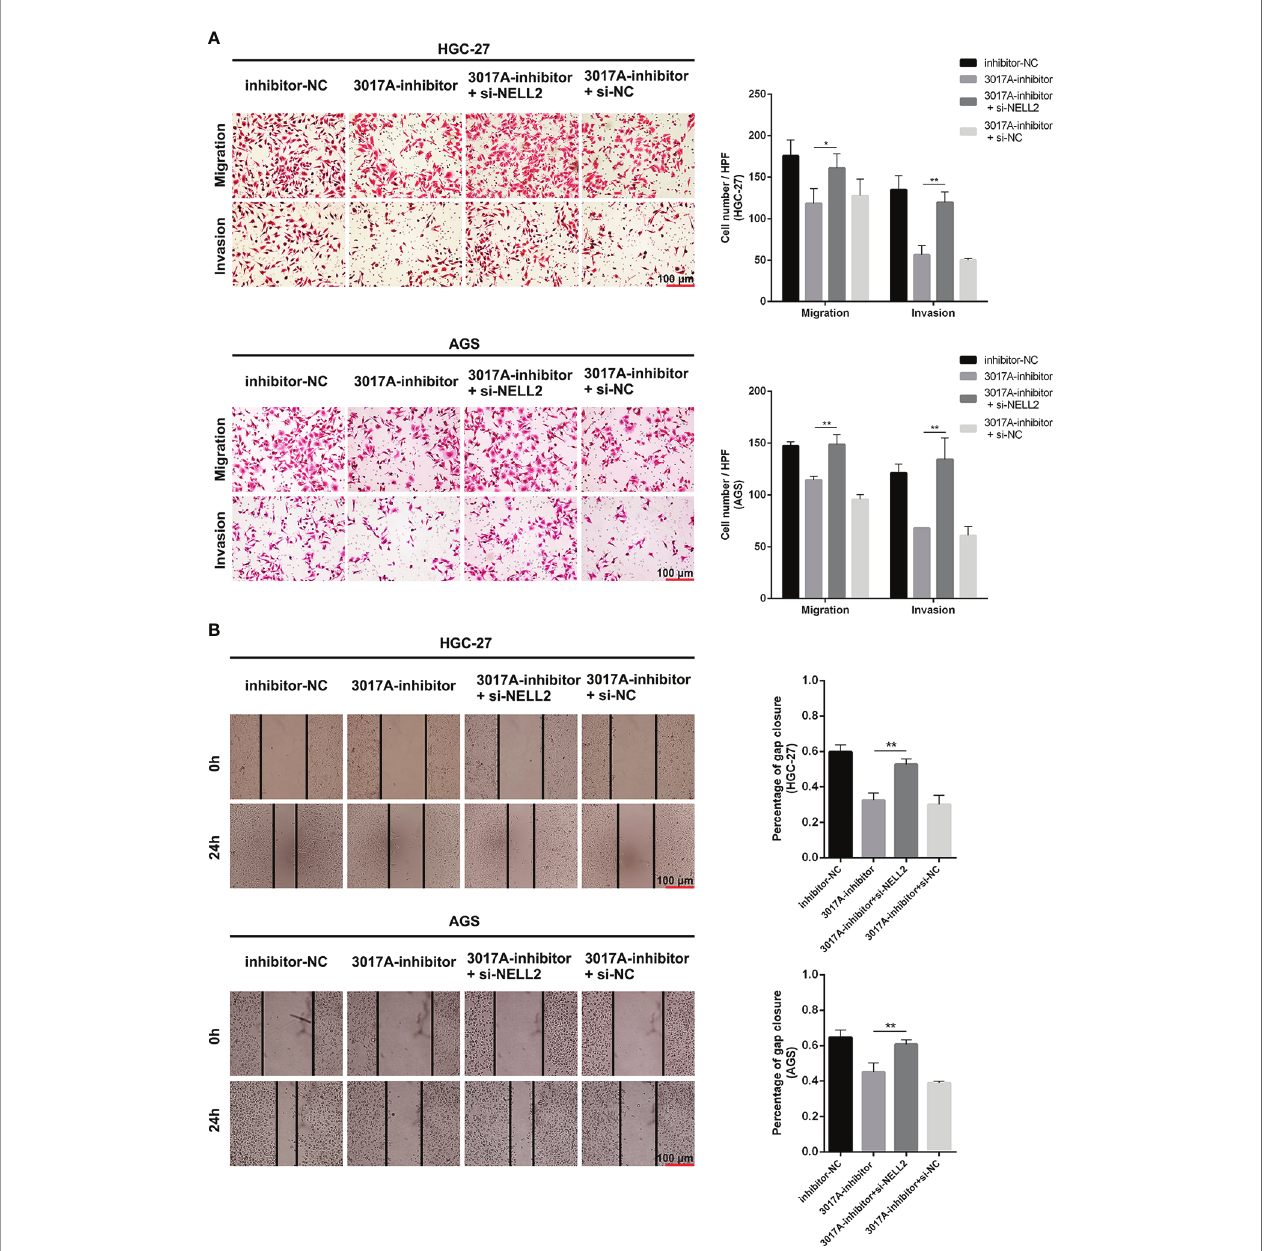
FIGURE 5 | Knockdown of NELL2 restores impaired migration and invasion ability induced by knocking down tRF-3017A. (A) GC cell migration and invasion ability were detected after co-transfected with tRF-3017A inhibitor and si-NELL2. (B) The scratch wound healing assay was used to detect GC cell migration ability after co-transfection. Data are shown as mean ± SD. NC, negative control. *P < 0.05; **P <